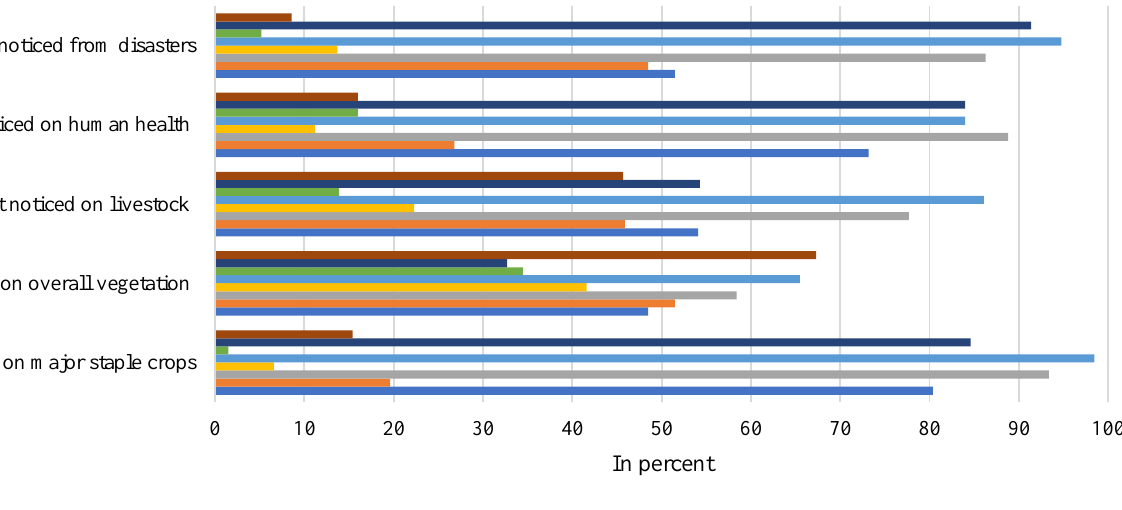
Figure 7. The observed impacts of climate change by local respondents’ in the various sectors in four physiographic regions of the trans-boundary KRB.